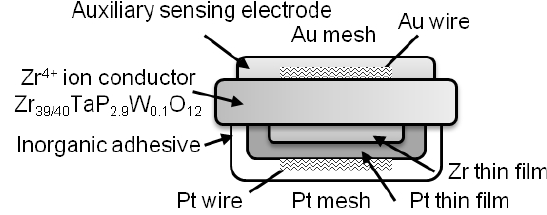
Figure 1. Schematic illustration of the SO 2 gas sensor based on the Zr 4 + ion conducting solid electrolyte.